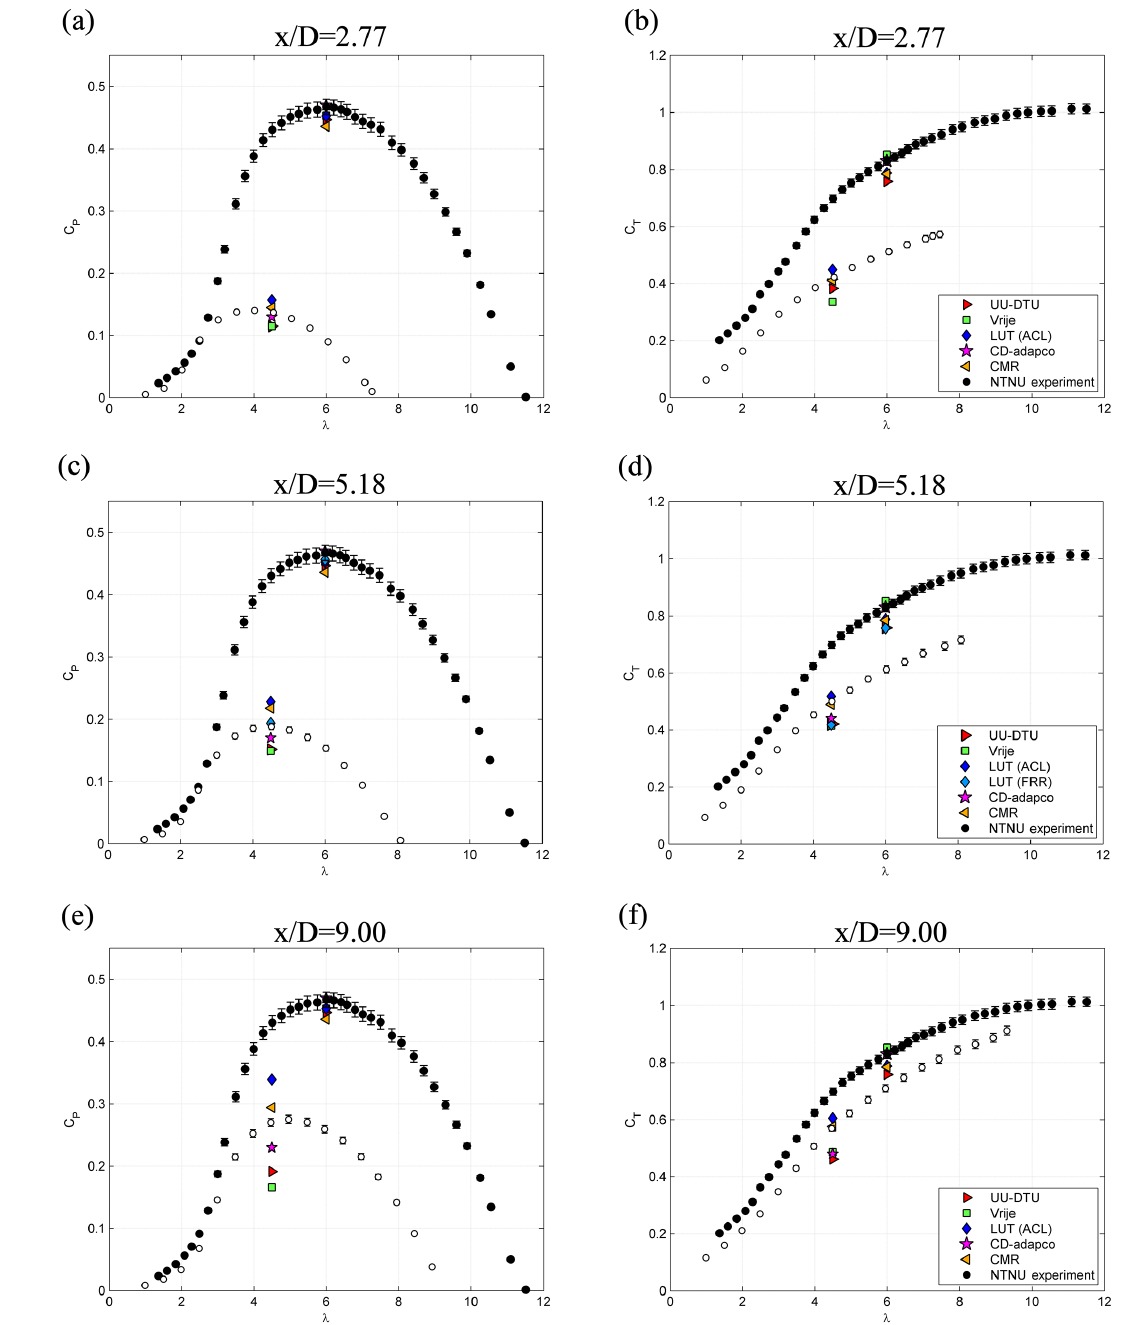
Figure 7. Power coefficient C P (a, c, e) and thrust coefficient C T (b, d, f) for T1 (filled symbols) and T2 (empty circles) compared for test cases B 1 , B 2 and B 3 . The downstream turbine T2 is positioned at x/D = 2.77 (a, b) , 5.18 (c, d) and 9.00 (e, f) downstream of T1. The upstream turbine T1 is operated at λ T1 = 6.0. The reference velocity is U ref = 11.5ms − 1